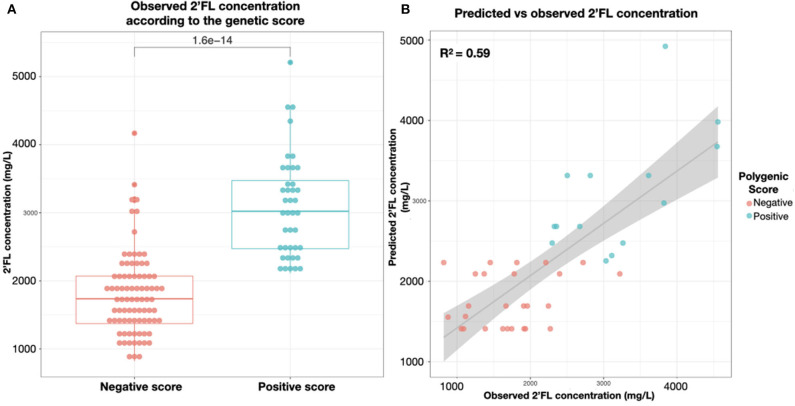
(A) 2′FL concentrations in milk (mg/L) of the 124 secretor mothers by genetic score categorization in high secretors positive score and moderate secretors zero or negative score. (B) In an independent test dataset, correlation between genetic score predicted and observed concentrations of 2'FL (mg/L) secreted in the milk of the individual mothers.